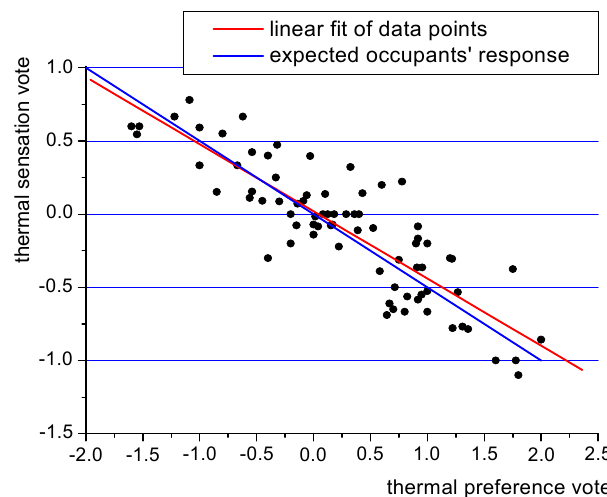
Figure 15. Relationship between average thermal sensation vote and average thermal preference vote based on 1369 questionnaires.